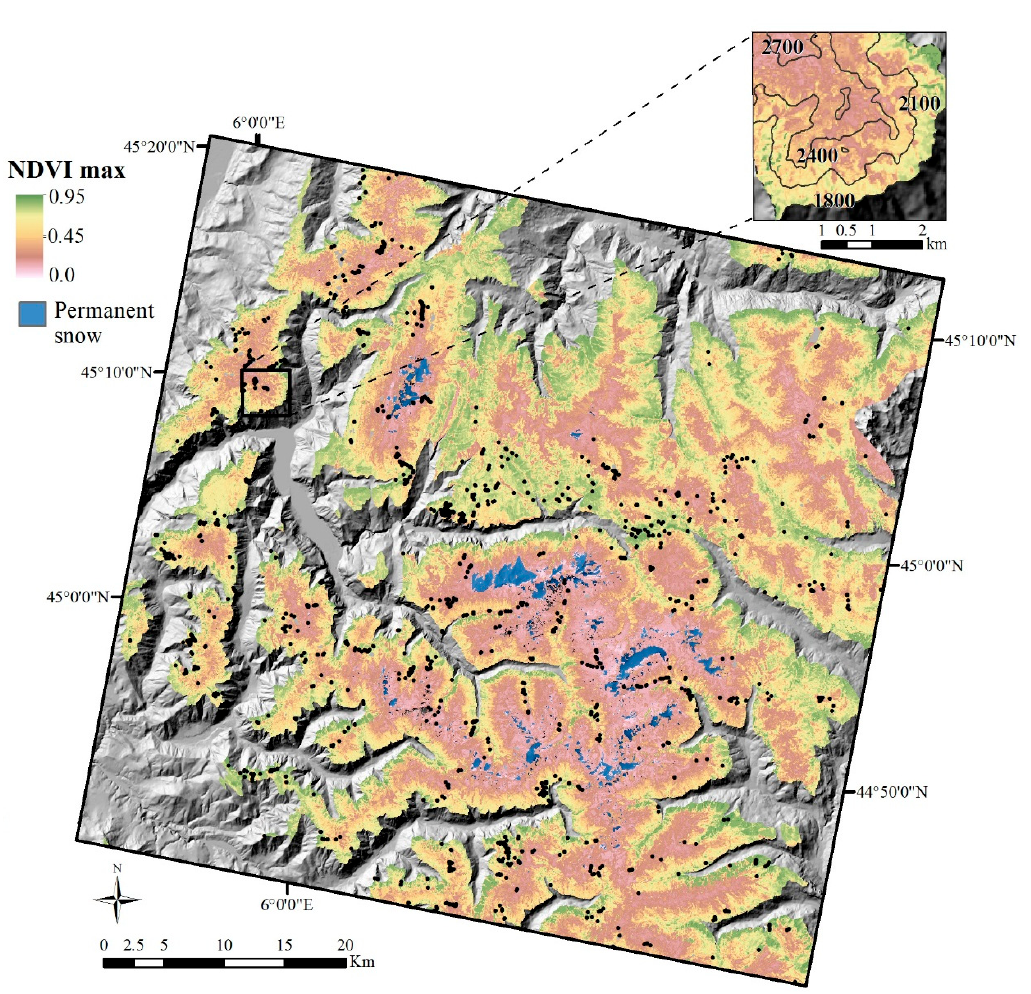
Figure 9. Peak NDVI (NDVI max ) estimated using SPOT-5 and Landsat-8 imagery for 2015. Pixels have a 25 m spatial resolution and correspond to alpine areas above 1800 m a.s.l. Points show the location of vegetation plots indicated at Section 3.2 ( n = 1272). The inset shows variation in NDVI max relative to elevation isolines. Permanent snow cover includes mostly glaciated surfaces.